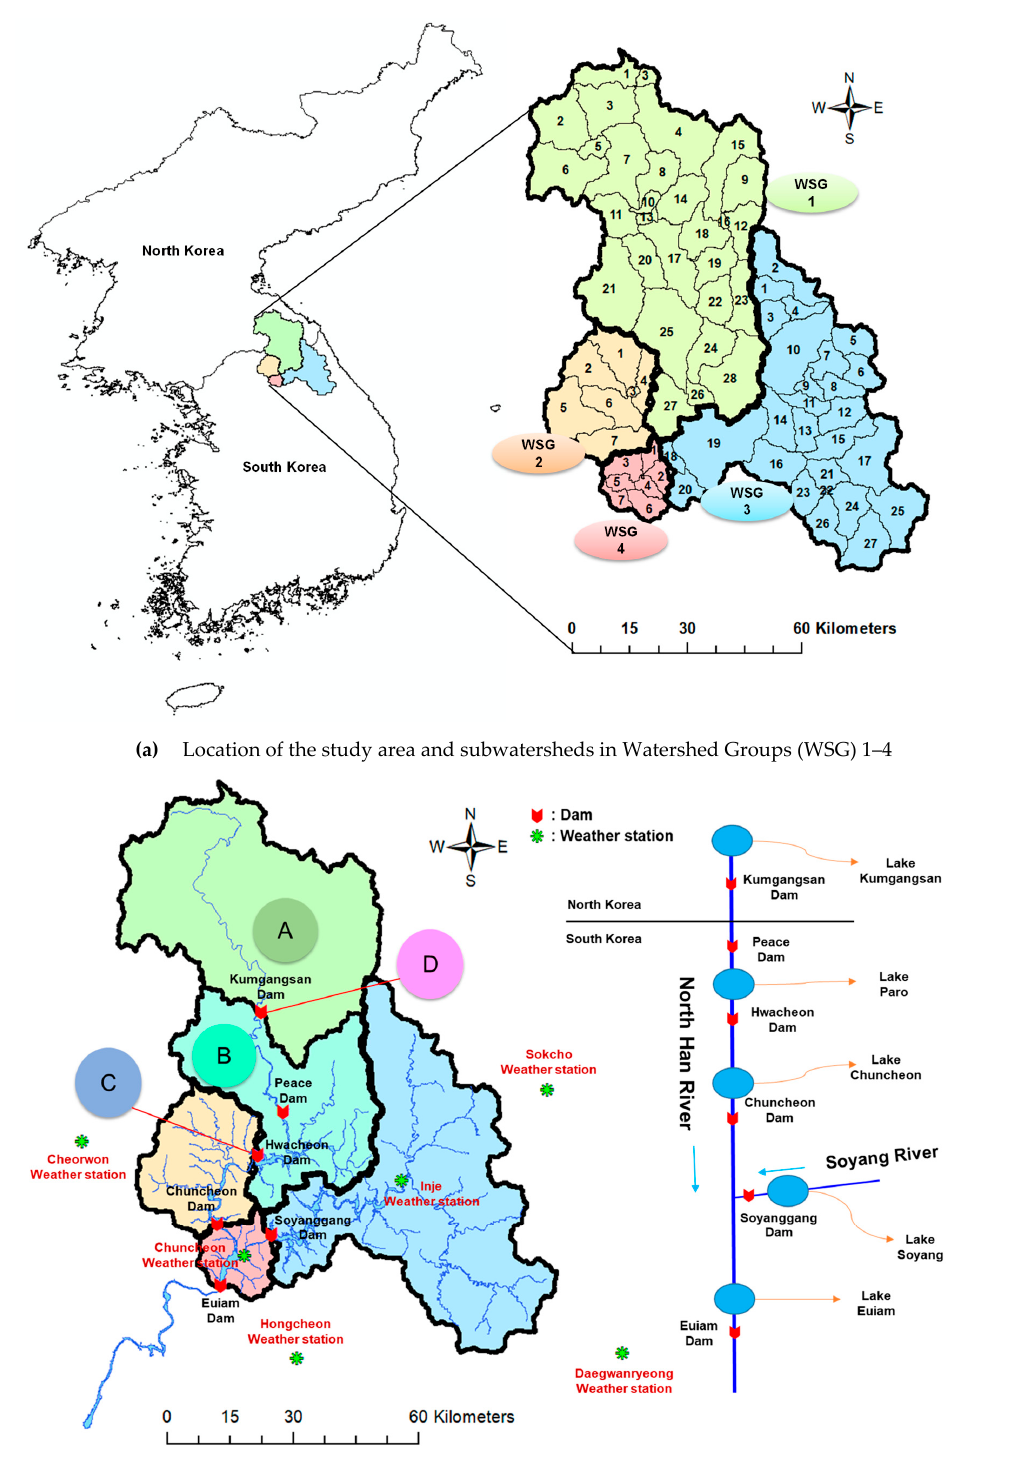
Figure 1. Location of the study area and dams: the estimated inflow into the Kumgangsan dam watershed (A), the estimated inflow into Hwacheon Dam watershed except for the Kumgangsan Dam watershed (B), and the total inflow into Hwacheon Dam (C). The discharge of Kumgangsan Dam (D = C −